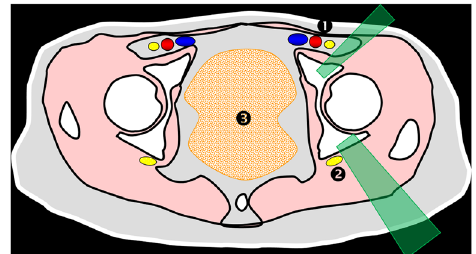
Fig. 14 Diagrammatic representation of the pelvis at the hip joint level showing the principal structures to avoid ( 1 femoral vessels and nerve, 2 sciatic nerve, 3 visceral structures) and the safe approaches ( green areas )